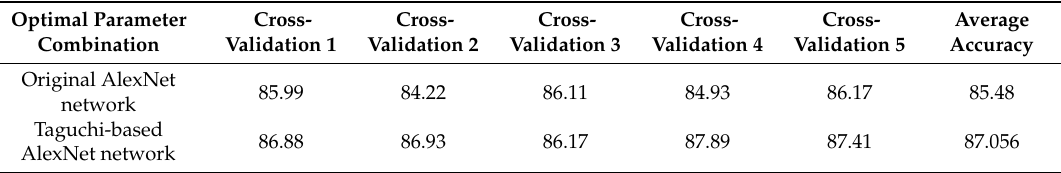
Table 7. Accuracy of the optimal parameter combination in CIA data